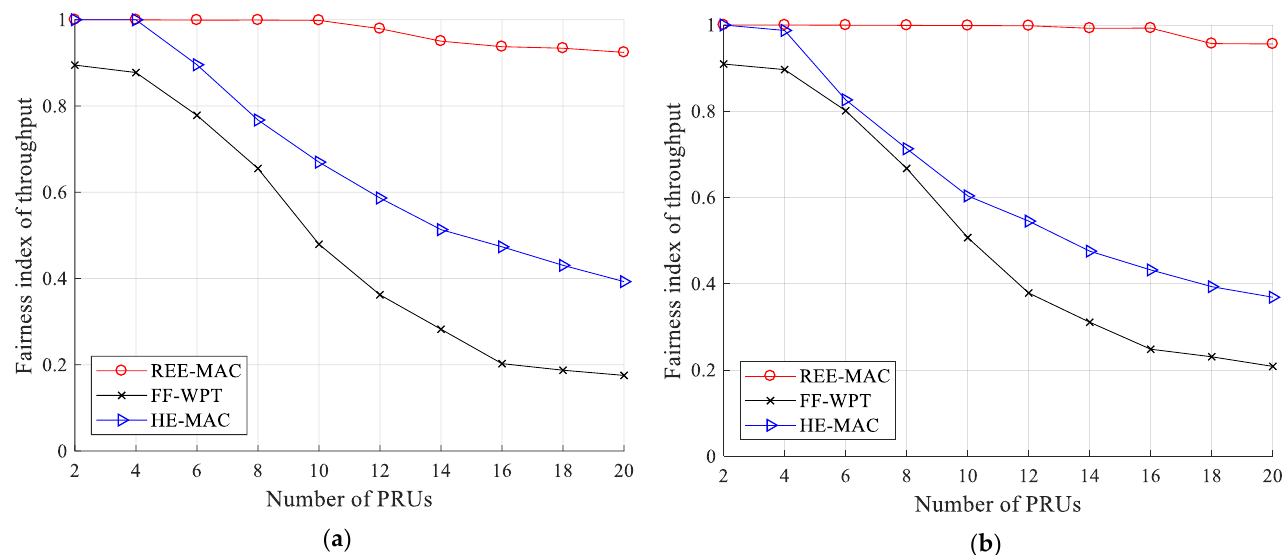
Figure 11. Fairness index for throughput: ( a ) packet size of 100 bytes; ( b ) packet size of 200